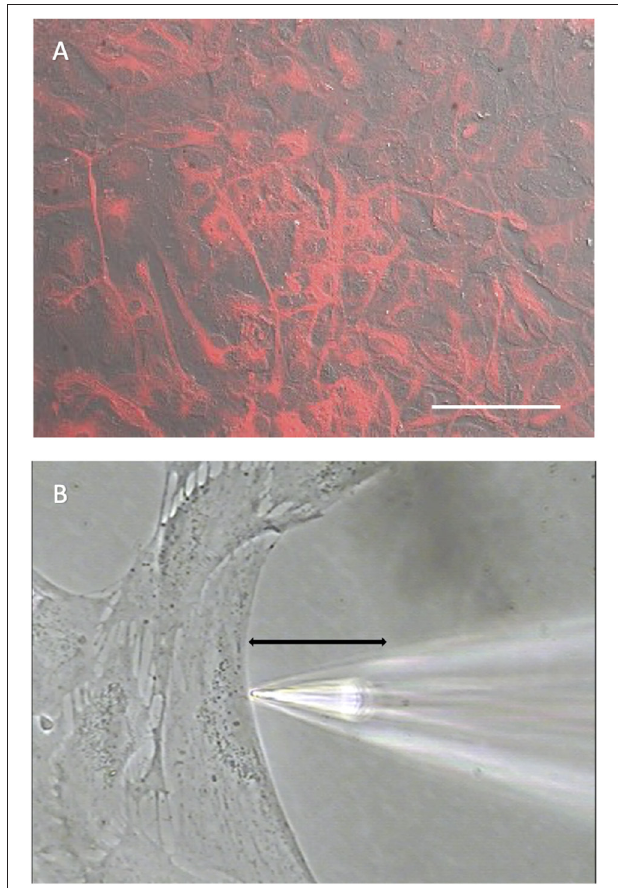
FIGURE 1 | Cells cultured from mouse hippocampus display robust staining for the glial cell marker GFAP. (A) Low power photomicrograph combining DIC image with fluorescent staining for GFAP in a confluent dish of cells cultured for 11 days from mouse hippocampus. Red indicates signal from GFAP. The signal was not observed in negative controls (not shown). White scale bar indicates 100 µ m. (B) High power photomicrograph depicting positioning of an H + selective microelectrode adjacent to a cell cultured from mouse hippocampus. Black line indicates the 30 µ m lateral movement the H + selective electrode would travel from the near pole adjacent to the plasma membrane (pictured) to a background location 30 µ m away.